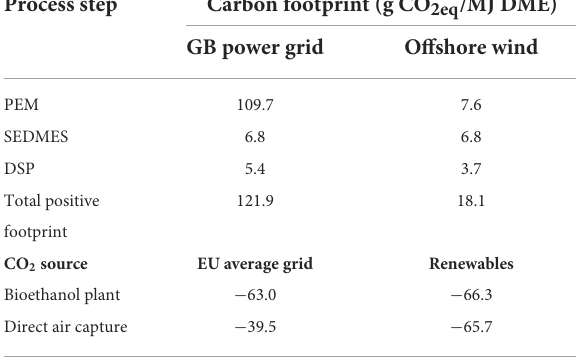
TABLE 1 The Power-to-X DME production footprint of the individual process